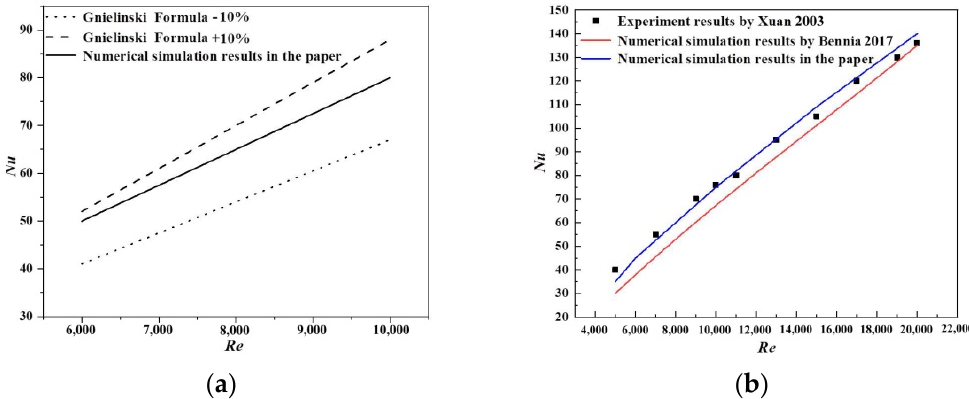
Figure 2. The comparisons between the numerical simulation results and other results. ( a ) Gnielinski formula calculation on pure water flow, ( b ) Xuan’s experimental results [34], and Bennia’s simulation results [35].